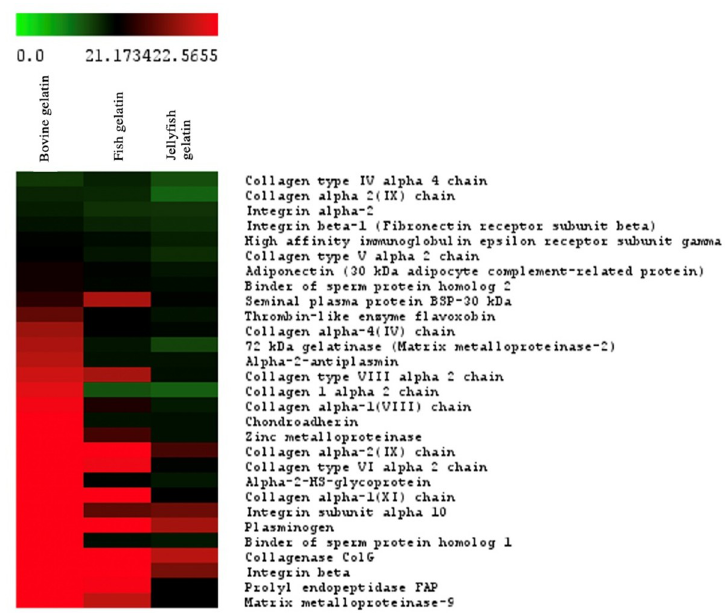
Fig 5. Heatmap showing the relative amount of proteins in each gelatin sample. A color bar of green to red color stands for the intensity of the total ion chromatogram from 0.0 to 22.5655.